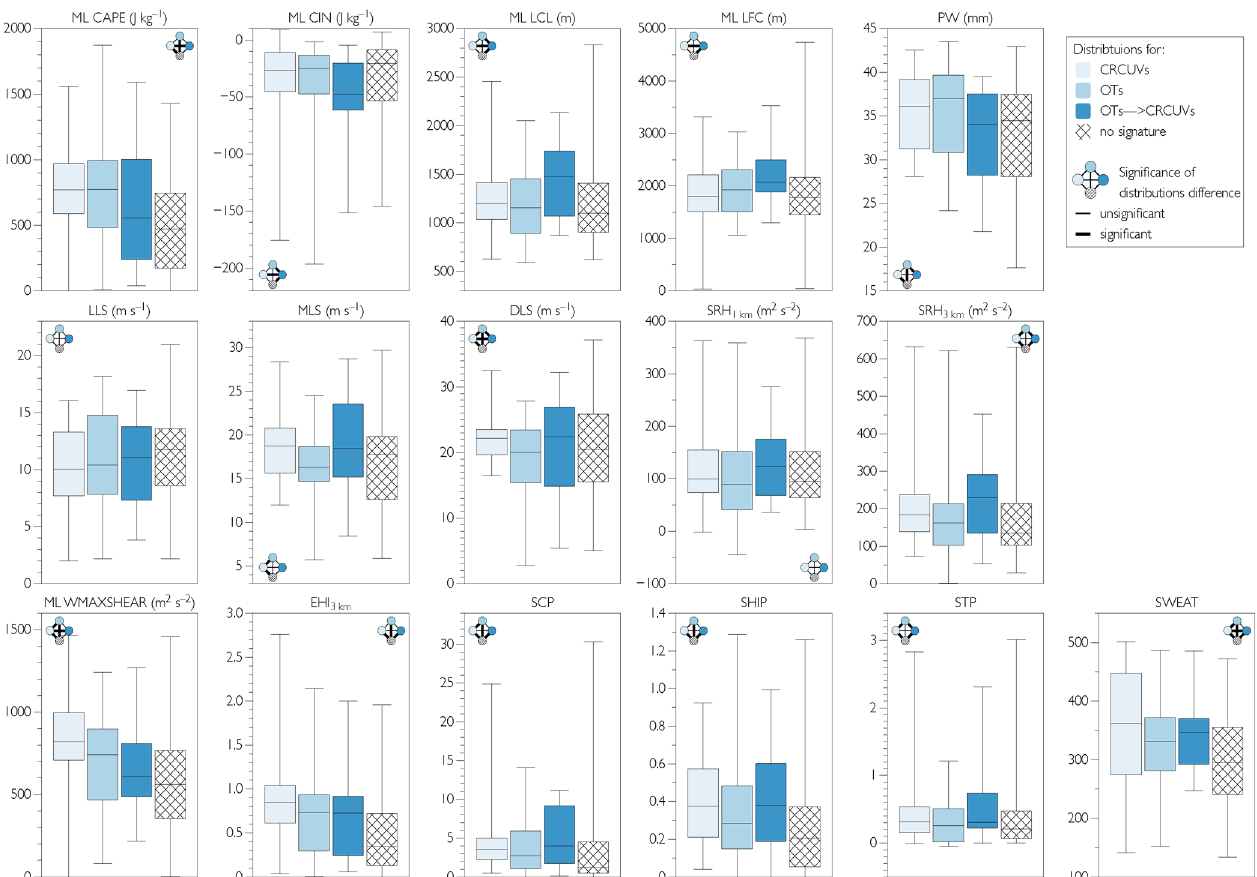
Figure 10. Distribution of various environmental variables separately for cloud top signatures including overshooting tops (88 events), cold-ring and cold-U/V signatures (61 events), OTs transformed to CRCUVs (31 events), and cases without signatures (111 events). The statistically significant difference is highlighted.